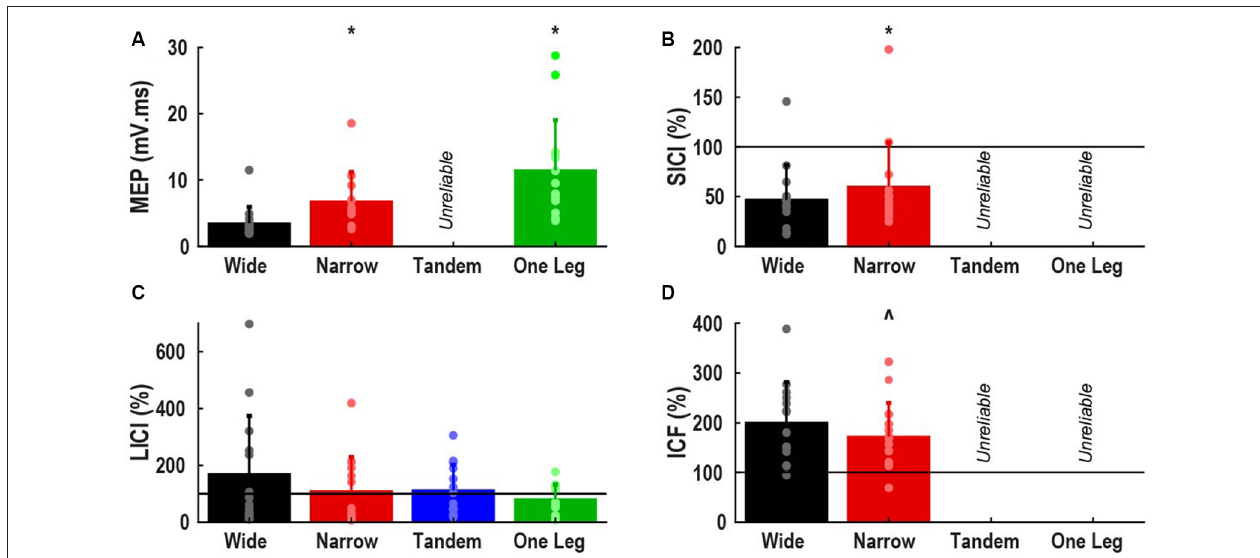
FIGURE 1 | Effect of task difficulty on neural excitability. (A) Motor evoked potential (MEP), expressed as area normalized to background EMG; (B) short interval intracortical inhibition (SICI); (C) long interval intracortical inhibition (LICI); (D) intracortical facilitation (ICF). (B–D) Expressed as percentage of control MEP, with values greater than 100% indicating facilitation. Bars represent mean and standard deviation, dots represent individual participant data. Horizontal lines indicate size of control MEP. ∗ Different from wide stance ( p < 0.05). ∧ Trend for difference with wide stance ( p = 0.07).